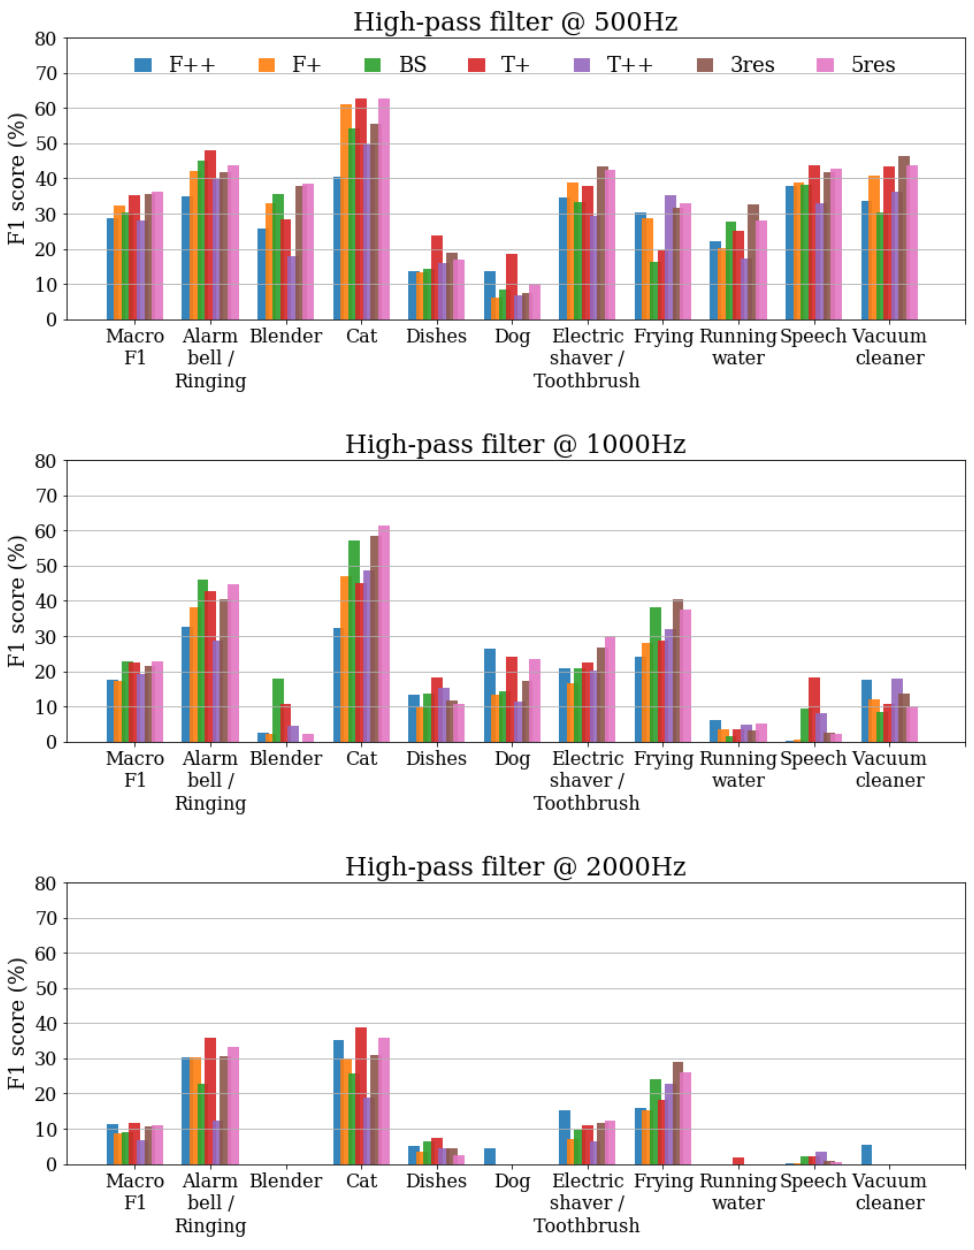
Figure 3. F 1 scores of single-resolution systems ( F ++ , F + , BS , T + , T ++ ) and multiresolution systems ( 3res , 5res ) over DESED Public Evaluation set applying a high-pass filter with cutoff frequencies of 500 Hz ( top ), 1000 Hz ( center ), and 2000 Hz ( bottom ). “Macro F1” shows average score over 10 target categories. Best viewed in